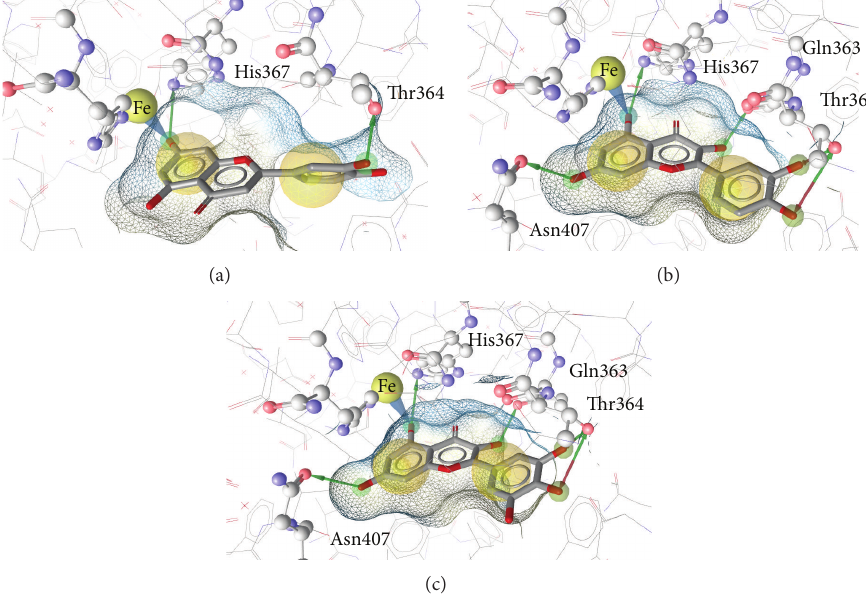
Figure 2: Docking poses of luteolin (a), quercetin (b), and myricetin (c). The blue cone marks a metal coordination feature formed with the iron by all three compounds. Additionally, all form hydrogen bonds with His367 and Thr364. Quercetin and myricetin also form H-bonds with Asn407 and